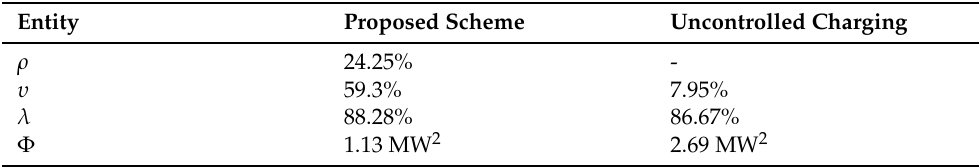
Table 4. Comparison of proposed scheme and uncontrolled charging on KEPCO X S/S-Z D/L feeder.